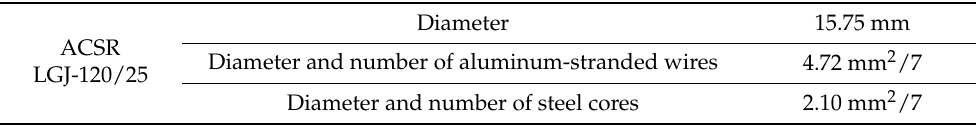
Table 1. Parameters of the LGJ-120/25.